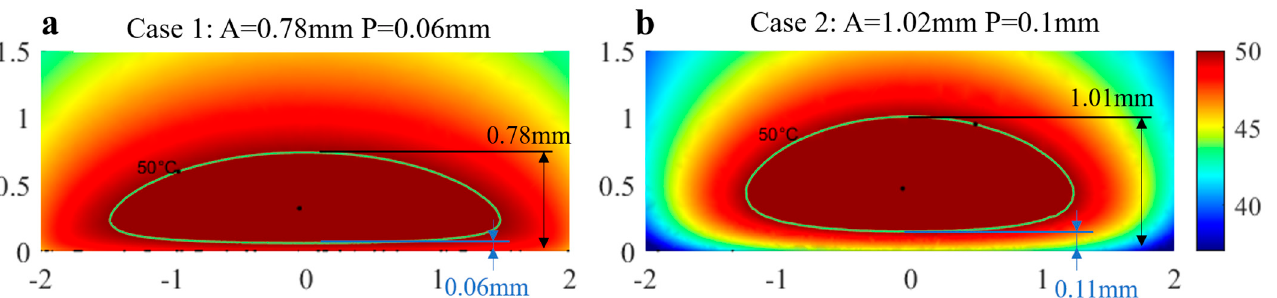
Figure 11. ( a ). Case 1: the objective ablation parameters were A = 0.78 mm and P = 0.06 mm; ( b ). Case 2: A =1.02 mm and P =0.1 mm. The real ablation parameters are marked with arrows.